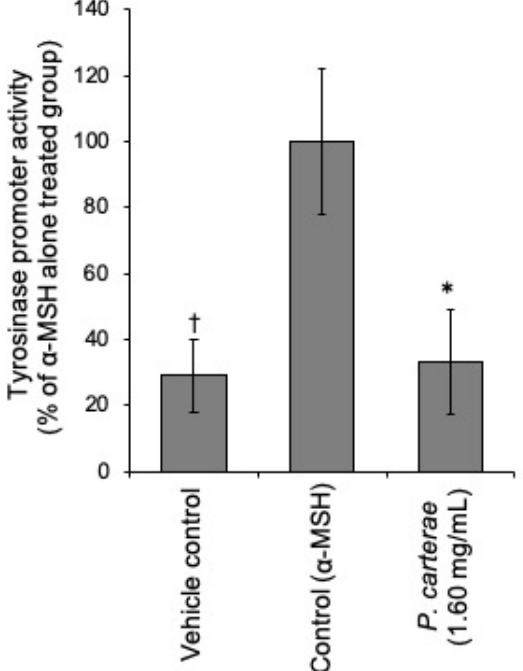
Figure 6. Effect of P. carterae on tyrosinase promoter activity. B16F1/pTyr-Luc cells were treated with or without P. carterae extract and stimulated with α -MSH (10 nM) for 24 h before a luciferase reporter assay was performed. †p < 0.01 versus control, *p < 0.01 versus α -MSH-only-treated.